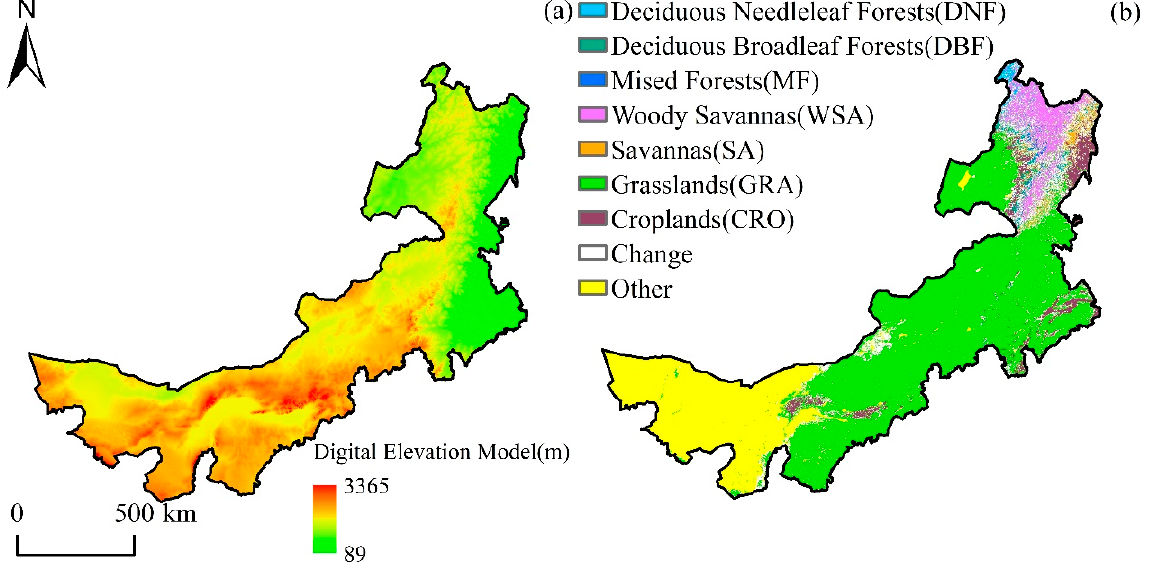
Figure 1. The research area’s geographic dispersion. Digital elevation model ( a ); various types of vegetation ( b ).